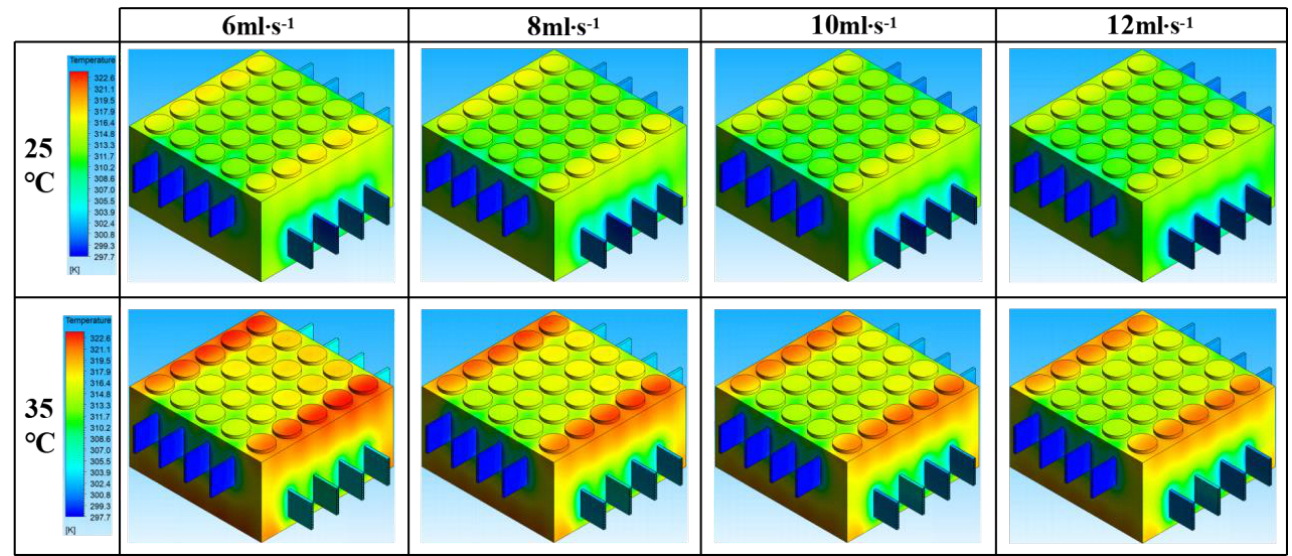
Figure 8. Temperature distribution of the CSG – LC module under different volume flow rate: ( a , e ) 6; ( b , f ) 8; ( c , g ) 10 and ( d , h ) 1 2 mL∙ s −1 at 25 and 35 °C. ( b , f ) 8; ( c , g ) 10 and ( d , h ) 12 mL · s − 1 at 25 and 35 ◦